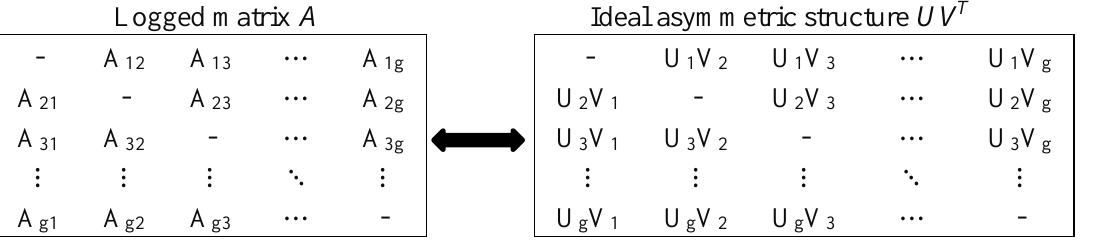
Figure 1. An illustration of detecting the asymmetric core/periphery structure. The objective is to minimize the sum of the squares of the off-diagonal differences between the logged matrix A and the ideal asymmetric structure UV T . Logged matrix A Ideal asymmetric structure UV